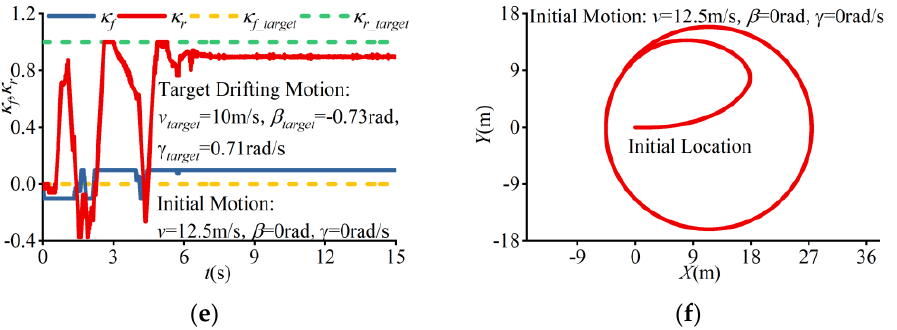
Figure 10. The simulation result with the initial motion as Group 4 in Table 3 to realize the target drifting motion as Group 2 in Table 2: ( a ) the variation curve of the velocity; ( b ) the variation cure of the sideslip angle; ( c ) the variation curve of the yaw rate; ( d ) the variation cure of the steering angle; ( e ) the variation curves of the TYDEX longitudinal slip ratios; ( f ) the position modification of the narrow tilting vehicle in the ground coordinates.